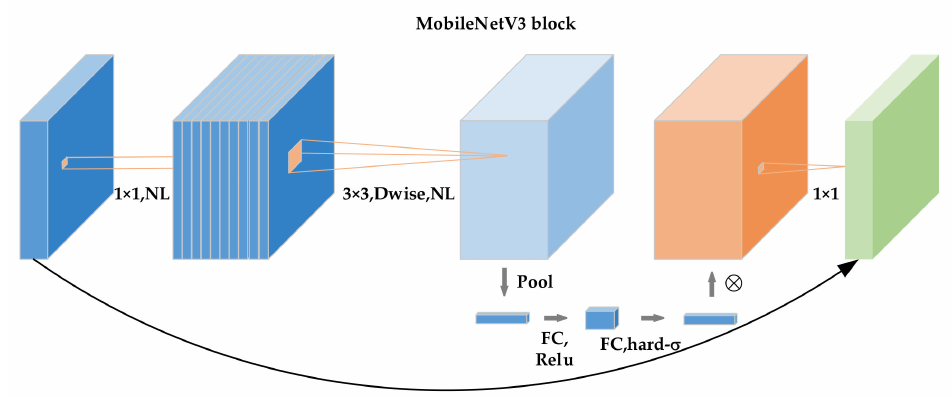
Figure 3. The structure of MobileNetV3 block. NL denotes the type of nonlinearity